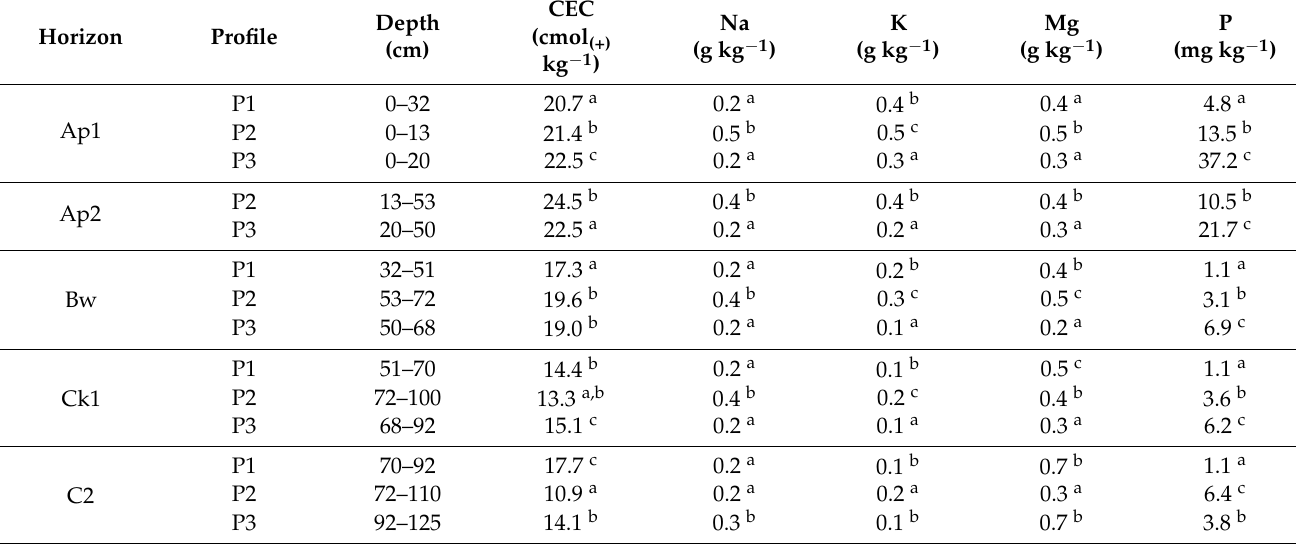
Table 3. Cation exchange capacity (CEC), available elements (Na, K, Mg), and phosphorus (P).